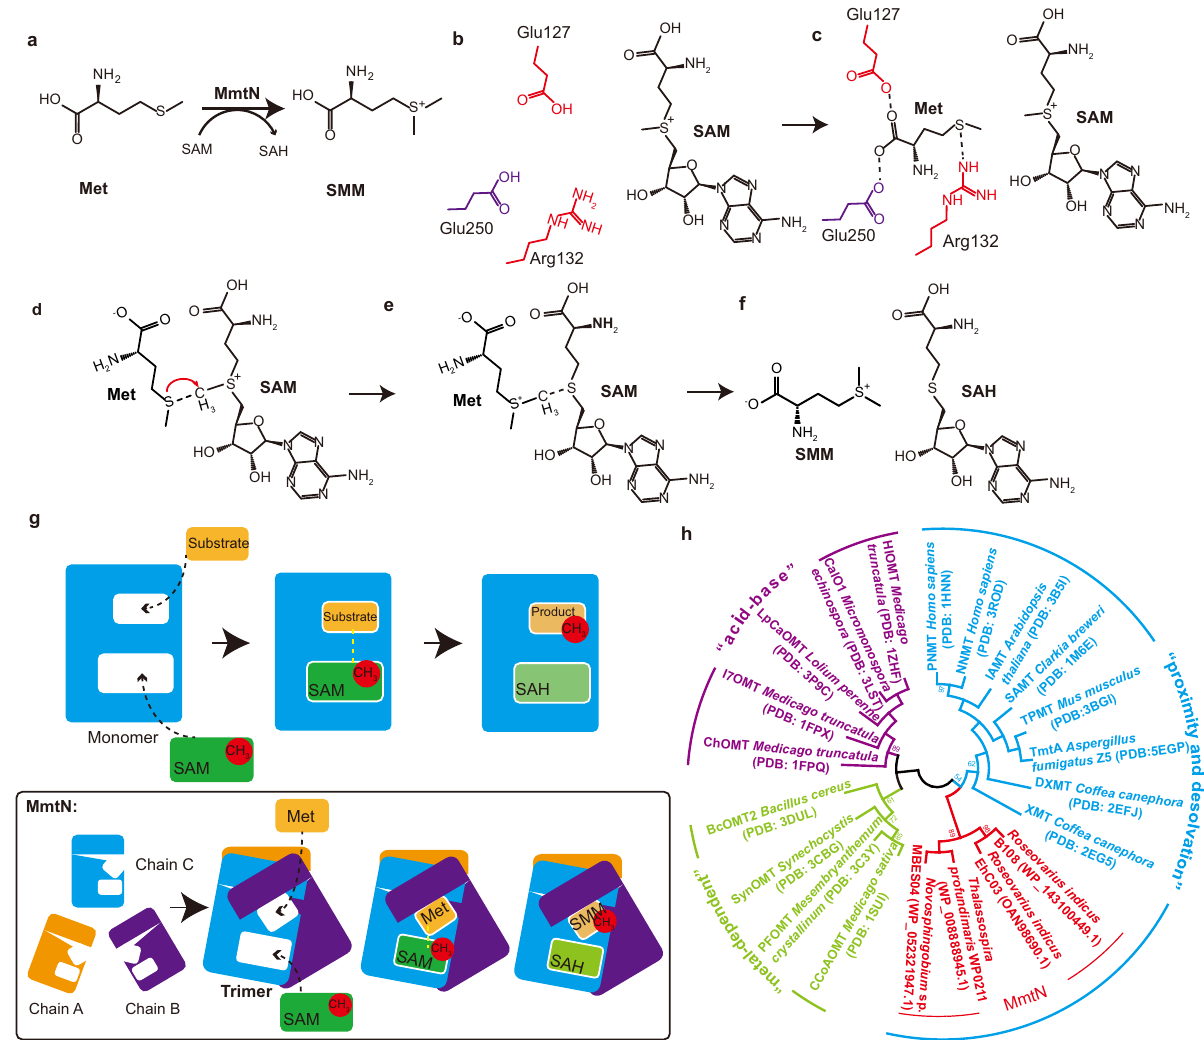
Fig. 6 The proposed mechanism of Met methylation by MmtN. a The chemical reaction scheme for the MmtN-catalyzed transfer of a methyl group from SAM to Met to generate SMM and SAH. b The SAM molecule is fi rstly bound in MmtN. In the absence of Met, the Met-binding pocket is exposed. MmtN residues involved in Met binding are colored in red and purple. c A Met molecule enters the binding site and is positioned by Glu127, Glu250, and Arg132. d The Met-SAM intermediate is formed. The red arrow indicates that the sulfur atom of Met attacks the methyl group of SAM. e The methyl group of SAM is transferred to Met. f Met is methylated, and SMM and SAH are generated. g The schematic plot of catalysis by MmtN and other SAM-dependent methyltransferases. MmtN catalysis is shown in a black box. h Maximum-likelihood phylogenetic tree of MmtN homologs and other SAM-dependent methyltransferases. Phylogenetic analysis was performed using MEGA version 6.0. Source data are provided as a Source Data fi